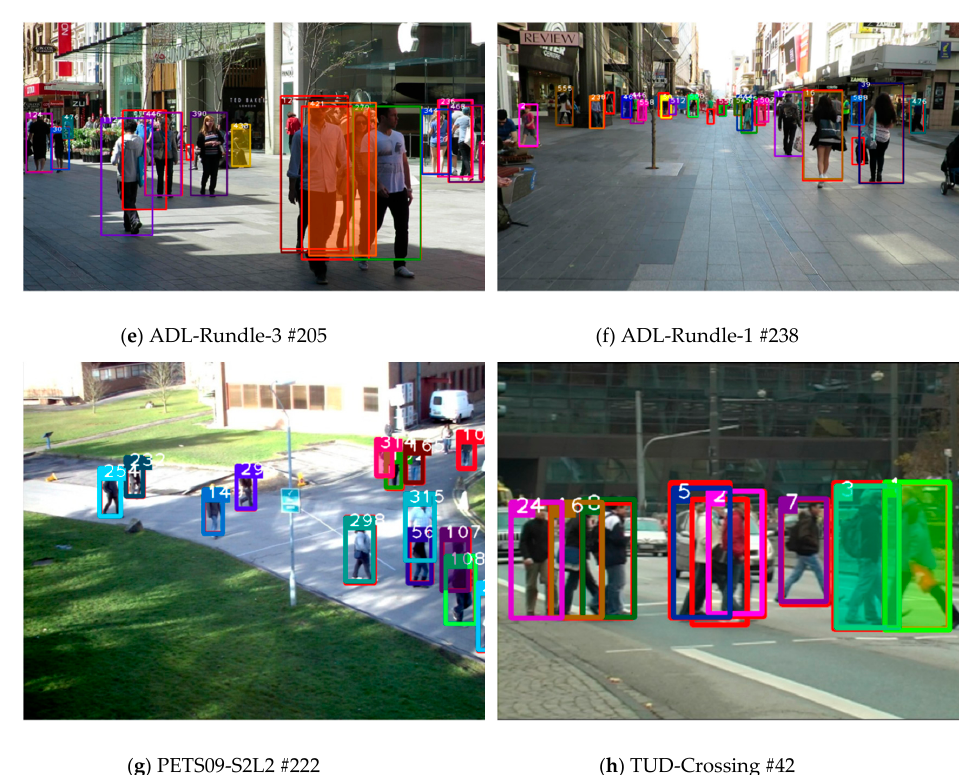
Figure 3. Exemplary qualitative tracking results for the MOT15 benchmark dataset. (a–d) are from a set of training images and (–h) are from a set of testing images. Following # is the individual frame number in each image sequence. Different trajectories are illustrated in different colors, with different identities marked in white. The red boxes without identities are detections, some of which have not been associated with trajectory. The filled boxes are low-confidence trajectories, while the unfilled rectangles are high-confidence trajectories.